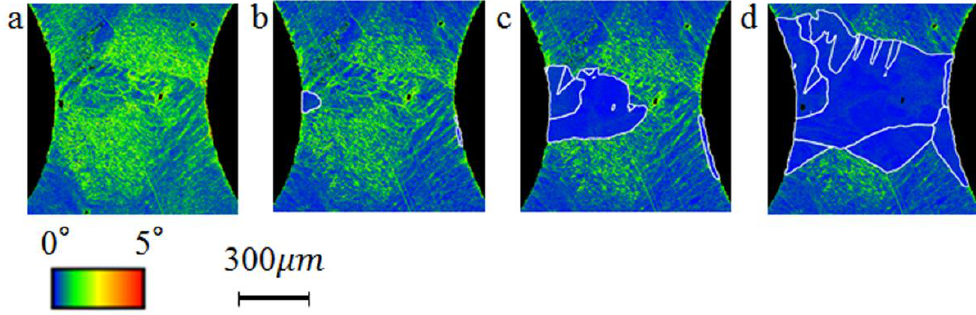
Figure 13. Microstructure evolution of specimen 3-2 at annealing time ( a ) 0 min; ( b ) 10 min; ( c ) 20 min; and ( d ) 60 min. Grain boundaries were highlighted with white lines.